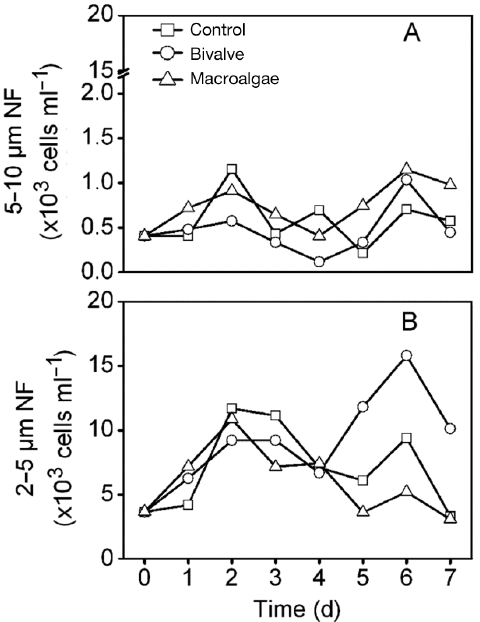
Fig. 9. Variations in abundance of (A) 5−10 µm nanoflagel- lates (NF) and (B) 2−5 µm NF in the enclosure